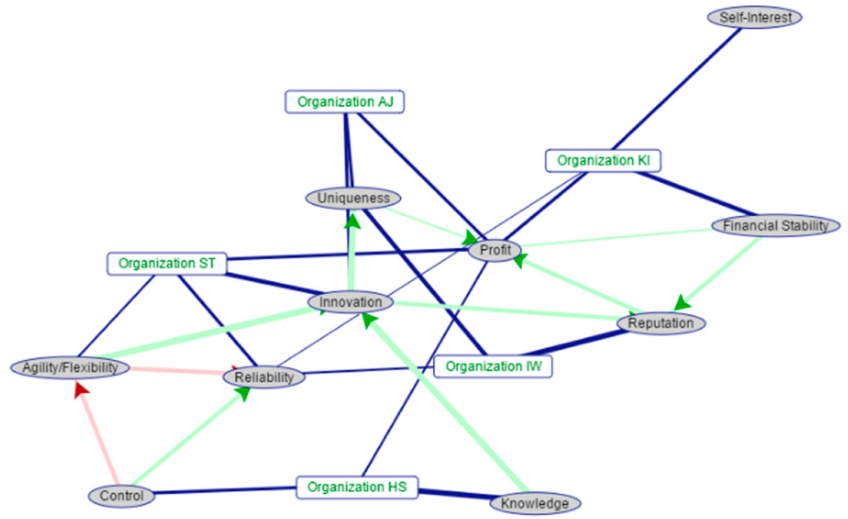
Figure 7. Core-Values Members Map—Potential Consortium 4.